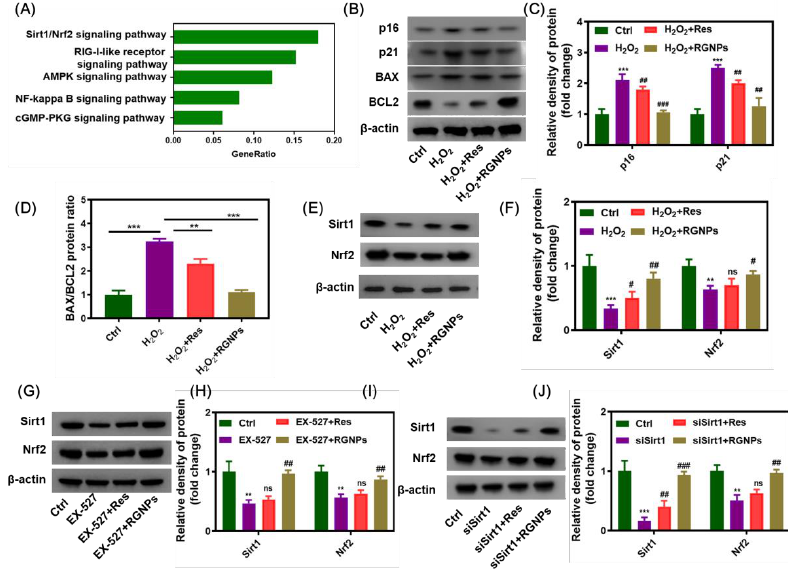
Figure 5. RGNPs inhibited cellular senescence via activation of Sirt1/Nrf2 pathway in vitro. ( A ) GEO analysis of Res involved signaling pathway (GSE184636). ( B ) Senescence-related proteins by H 2 O 2 , H 2 O 2 + Res and H 2 O 2 + RGNPs treatment in HLECB3 cells, such as p16, p21, BAX and BCL2 were determined by western blotting. ( C ) Relative density of proteins (p16 and p21) by H 2 O 2 , H 2 O 2 + Res and H 2 O 2 + RGNPs treatment in HLECB3 cells. ( D ) BAX/BCL2 protein ratio by H 2 O 2 , H 2 O 2 + Res and H 2 O 2 + RGNPs treatment in HLECB3 cells. ( E ) Sirt1 and Nrf2 proteins by H 2 O 2 , H 2 O 2 + Res and H 2 O 2 + RGNPs treatment in HLECB3 cells were determined by western blotting. ( F ) Relative density of proteins (Sirt1 and Nrf2) by H 2 O 2 , H 2 O 2 + Res and H 2 O 2 + RGNPs treatment in HLECB3 cells. ( G ) Sirt1 and Nrf2 proteins by EX-527 (Sirt1 inhibitor), EX-527 + Res and EX-527 + RGNPs treatment in HLECB3 cells were determined by western blotting. ( H ) Relative density of proteins (Sirt1 and Nrf2) by EX-527, EX-527 + Res and EX-527 + RGNPs treatment in HLECB3 cells. ( I ) Sirt1 and Nrf2 proteins by siSirt1, siSirt1 + Res and siSirt1 + RGNPs treatment in HLECB3 cells were determined by western blotting. ( J ) Relative density of proteins (Sirt1 and Nrf2) by siSirt1, siSirt1 + Res and siSirt1 + RGNPs treatment in HLECB3 cells. ** and *** indicate H 2 O 2 or EX-527 or siSirt1 vs. Ctrl; #, ## and ### indicate H 2 O 2 + Res, EX-527 + Res, siSirt1 + Res or H 2 O 2 + RGNPs, EX-527 + RGNPs, siSirt1 + RGNPs vs. H 2 O 2 , EX-527, siSirt1; ns indicated statistically insignificant .